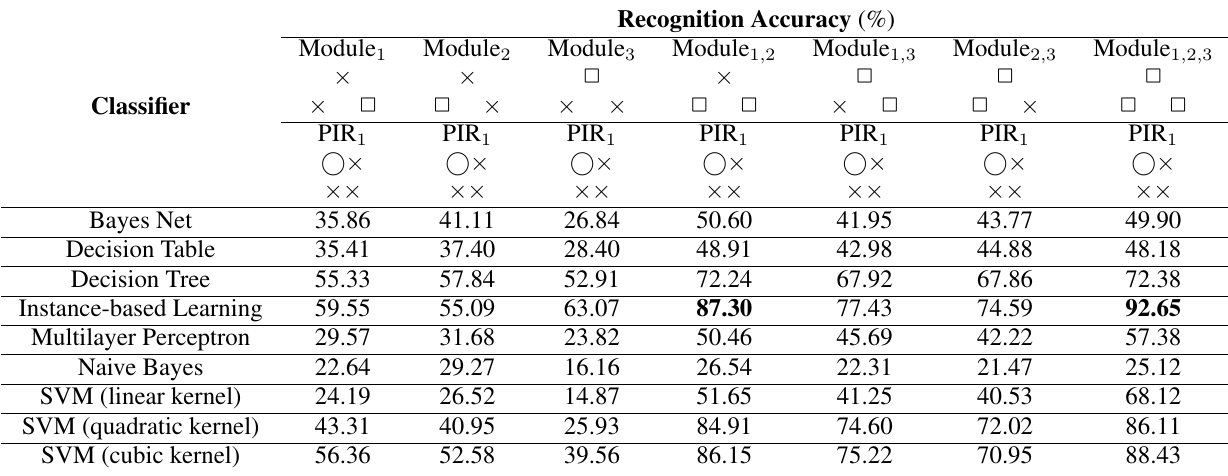
Table 8. Comparison of the recognition accuracy (%) of identifying walking subjects based on the raw data set (PIR ) with respect to the number of 1